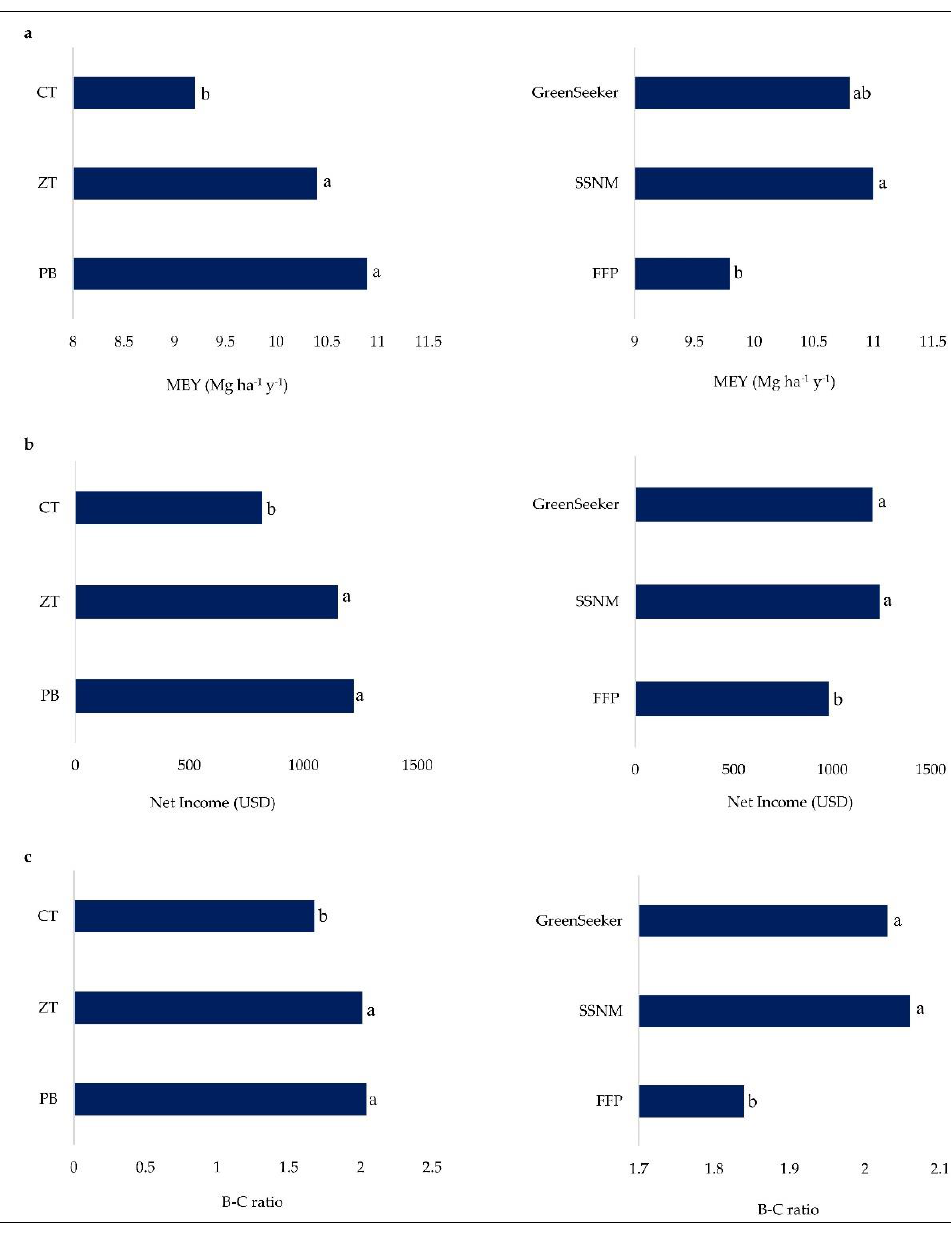
Figure 5. ( a ) Maize equivalent yield (MEY); ( b ) Net returns; ( c ) Benefit–cost ratio under different tillage and nutrient management options [same letters after bars represent no statistical difference ( p ≤ 0.05); CT, ZT, and PB denote conventional tillage, zero tillage/direct seeding, and permanent bed, respectively; SSNM, and FFP denote site-specific nutrient management using Nutrient Expert Softw are, and farmers’ practice, respectively] .